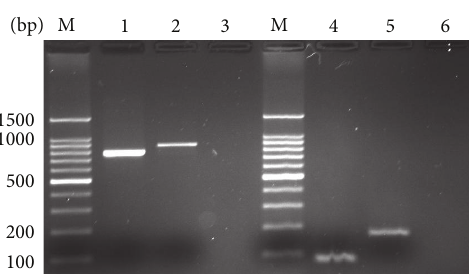
Figure1:ConventionalPCRresultsofPRRSVNSP2gene.M:100bp marker; 1 and 4: HP-PRRSV (GD) strain; 2 and 5: PRRSV (CH-1a) strain; 3 and 6: